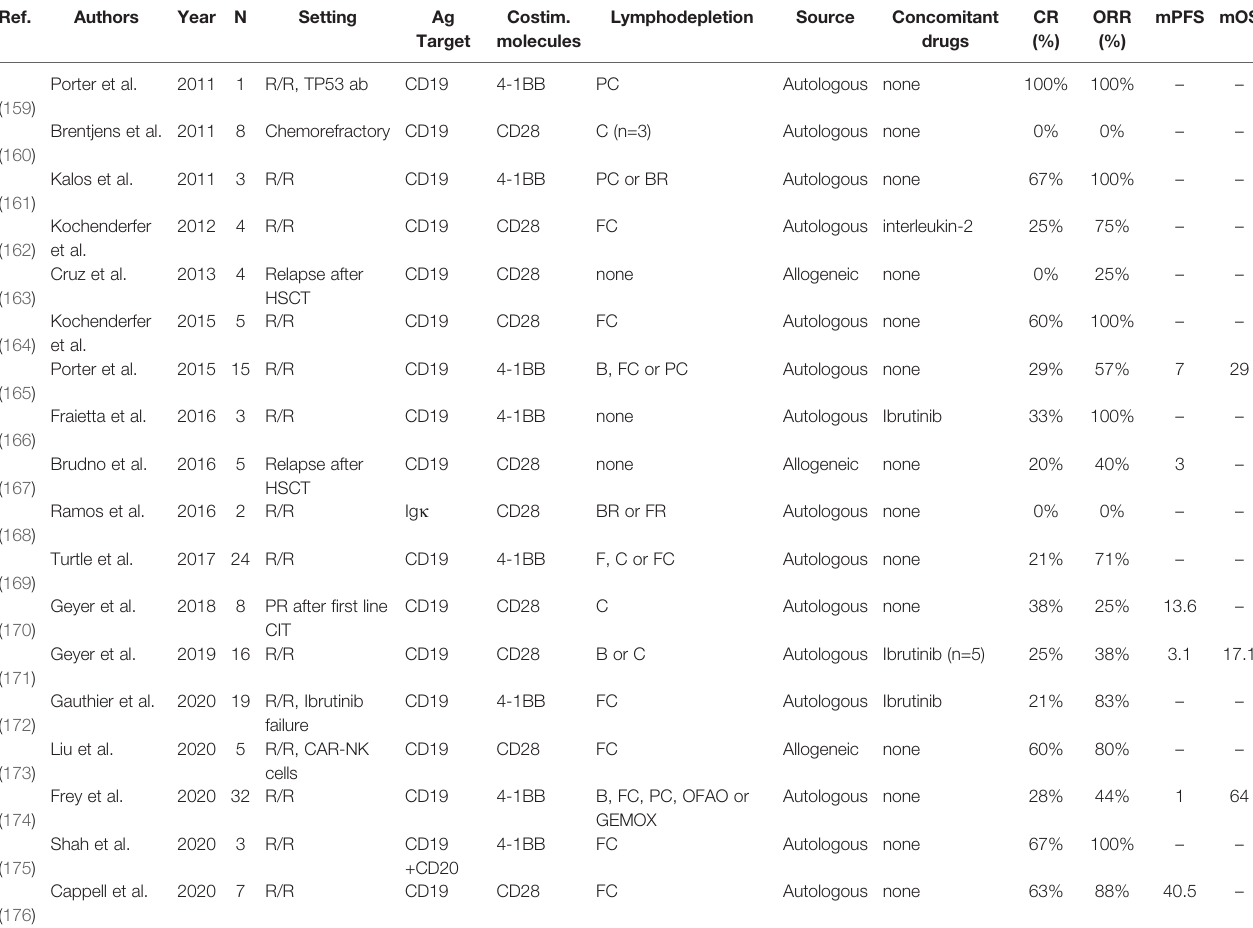
TABLE 11 | An overview trials evaluating the ef fi cacy CAR-T/NK cell trials in patients with CLL.